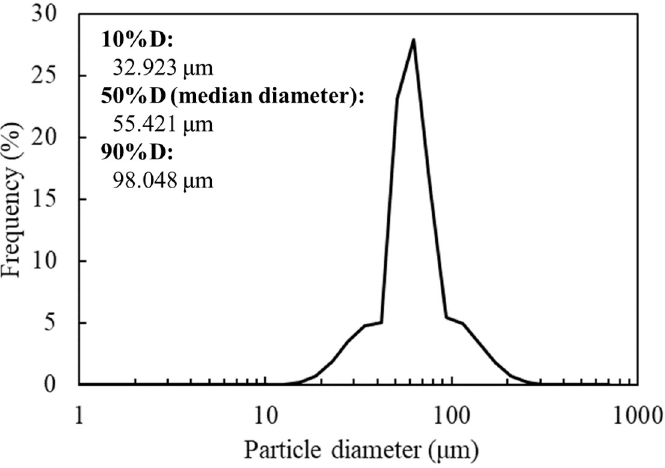
Figure 3. Size distribution of the carbon materials. The frequency of the particle sizes of the carbon materials was shown by spectrum. The expressions 10%D, 50%D (median diameter), and 90%D mean 10%, 50% and 90% of the cumulative distribution of the carbon materials.